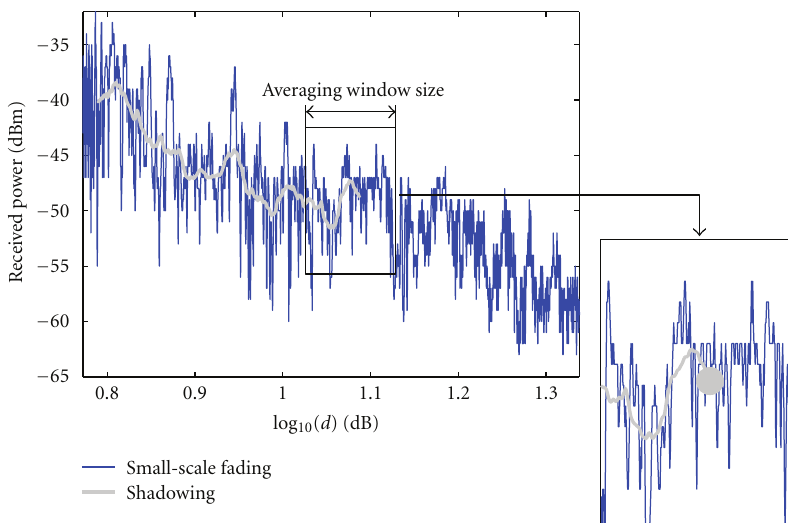
Figure 8: Comparison of Nakagami and lognormal for the distribution of small-scale fading—(a) pdf and (b) cdf.